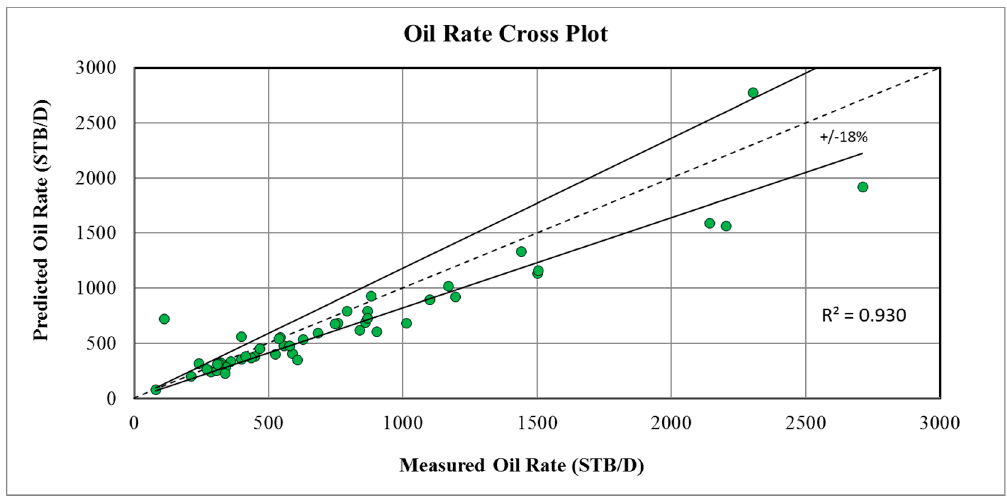
Figure 14. Predicted vs measured oil rate using the Colebrook correlation.